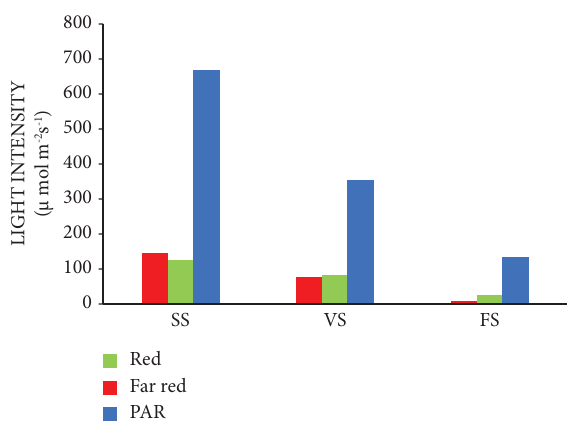
Figure 1: Red, far-red, and photosynthetically active radiations (A) at seedling, vegetative, and fowering stage under the intercropping canopy during the growth period at Hawassa. Where, SS � seed- lingstage, VS � vegetativestage, FS � foweringstage.